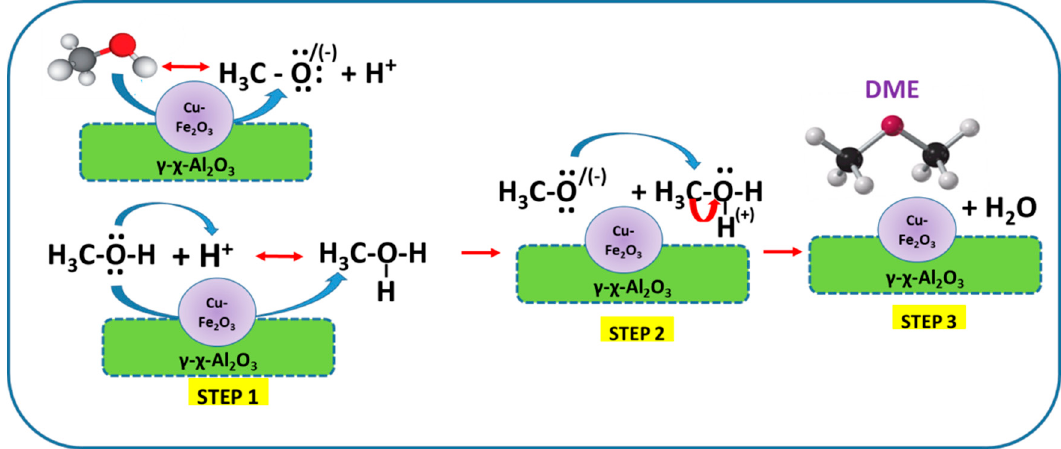
Figure 8. The possible reaction mechanism of methanol dehydration to DME over Cu-Fe 2 O 3 / γ -Al 2 O 3 catalyst (adopted from [102] with permission from Elsevier License No 5015231376777).